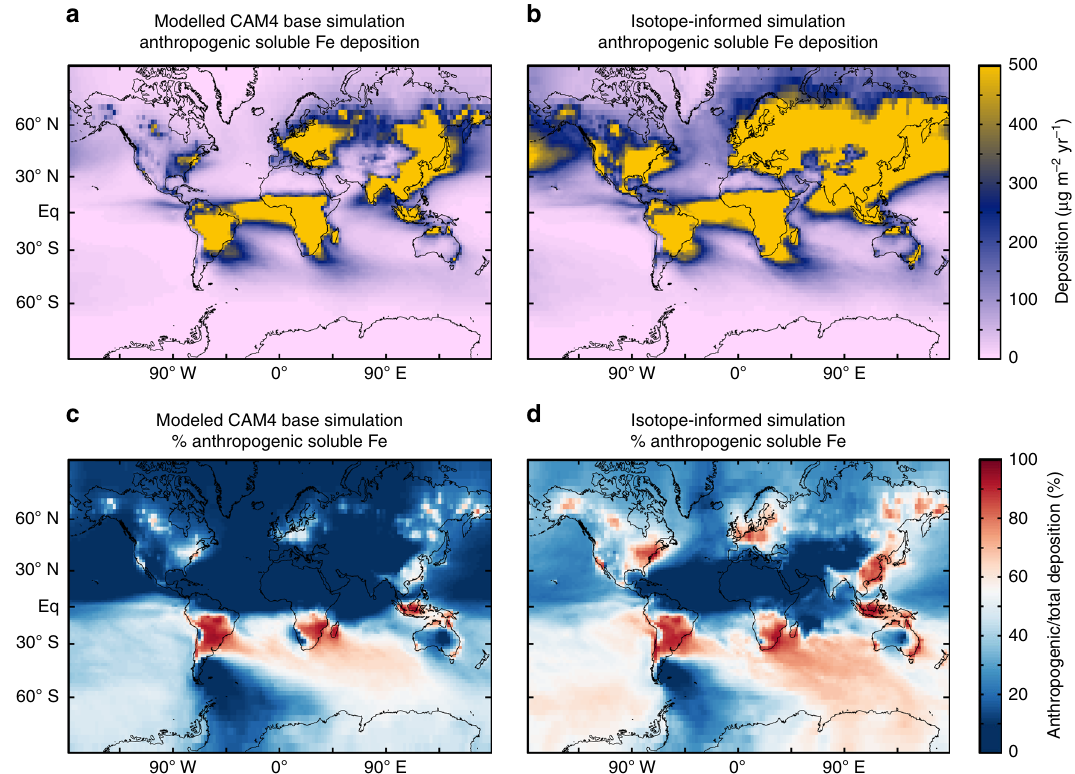
Fig. 6 Global impact on modeled deposition of soluble Fe. CAM4 isotope-re fi ned scenario compared with baseline CAM4 simulation of Scanza et al. 49 (see Fig 3; 5× increased anthropogenic Fe, and reducing solubilization of mineral dust at source to 10%). Panels a and c show the CAM4 base simulation, and b and d show the CAM4 isotope-re fi ned scenario. Anthropogenic soluble Fe deposition was calculated as fossil fuel + biofuel + fi re soluble Fe deposition. Percentage of anthropogenic soluble iron was calculated as anthropogenic soluble Fe deposition divided by anthropogenic + mineral dust soluble Fe